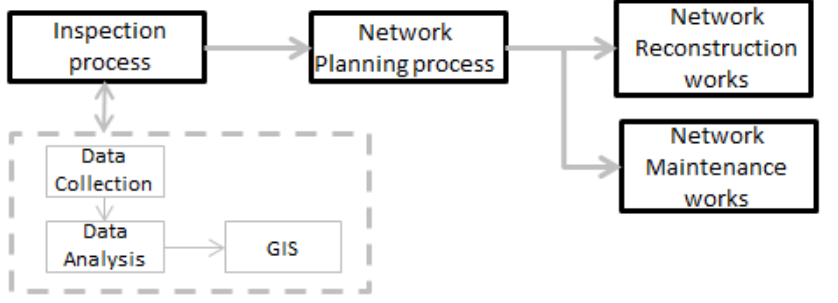
Figure 15. Data-based inspection process implementation in the network management process.